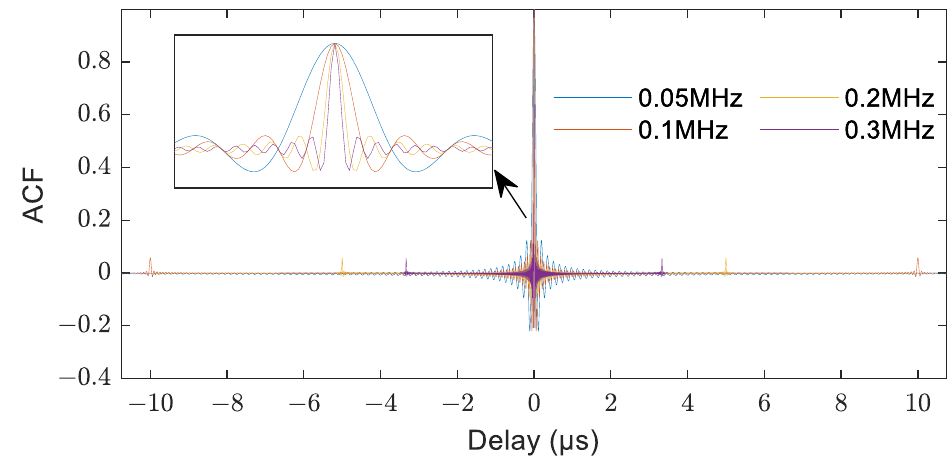
Figure 5. The ACF with different subcarrier intervals.